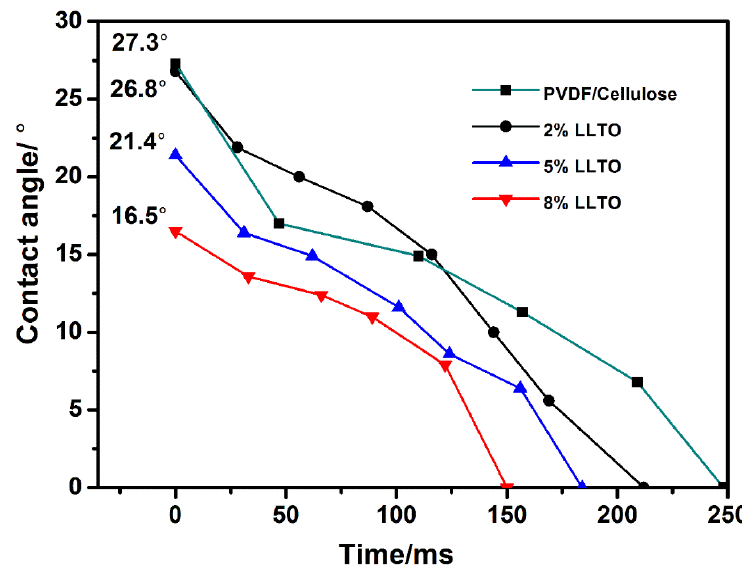
Figure 4. Surface contact angle of PVDF-HFP/cellulose and LLTO composite nanofibrous membrane. Table 2. Porosity, electrolyte uptake, ionic conductivity of PVDF-HFP/cellulose and LLTO composite nanofibrous separators.